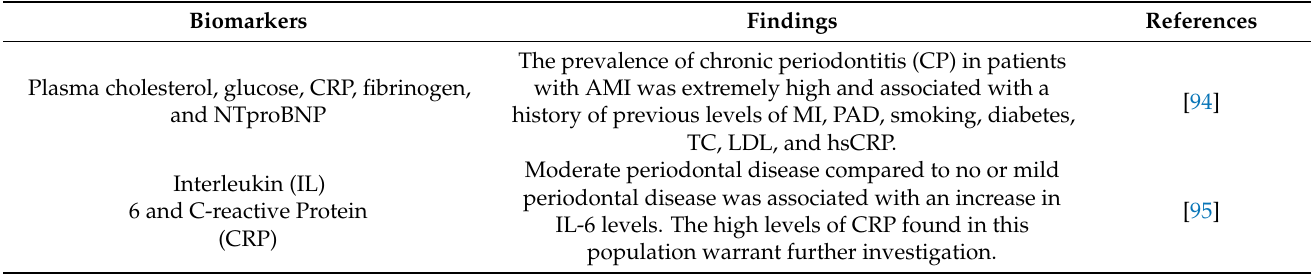
Table 3. Biomarkers and their association between periodontitis and